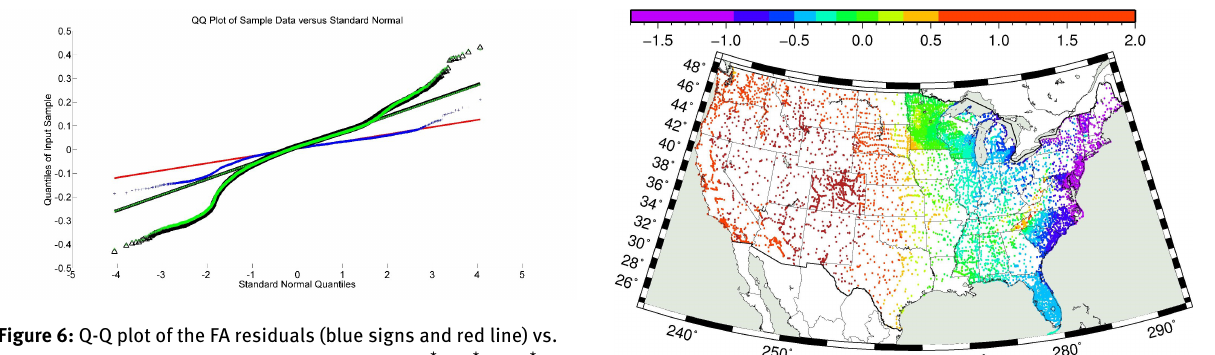
Figure 6: Q-Q plot of the FA residuals (blue signs and red line) vs. the counterparts both from the linear models ˜ y = β * 0 + β * 1 φ + β * 2 λ + ϵ (dark triangles and dark line) and ˜ y = β * 0 + β * 1 φ + β * 2 λ + β * 3 h + ϵ (green stars and green line) in Table 1.